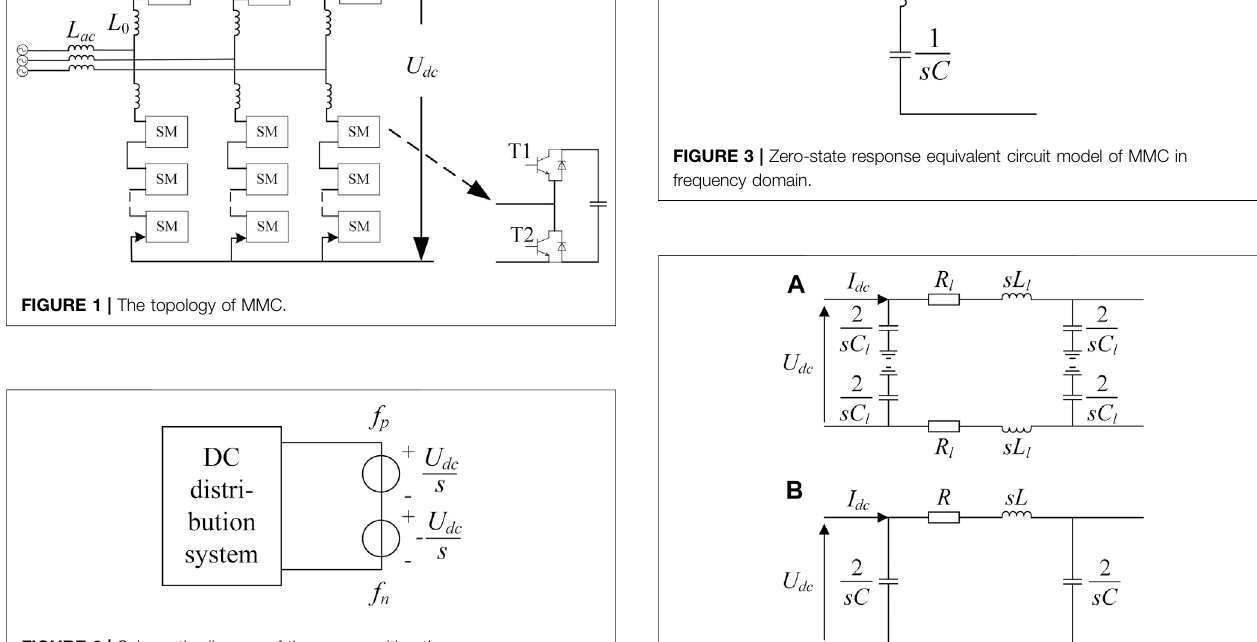
FIGURE 2 | Schematic diagram of the superposition theorem.